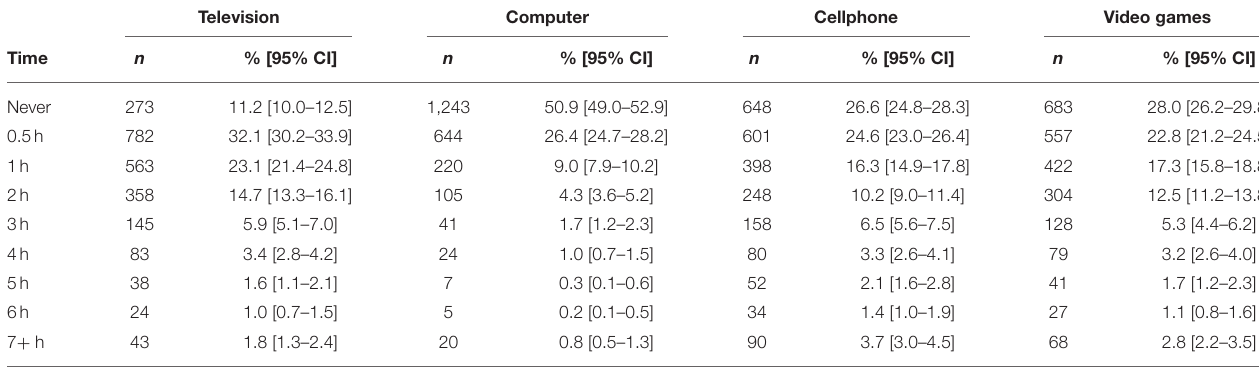
TABLE 2B | Percentage of students by time spent using technological devices during weekdays ( n = 2,309; Missing data = 131).